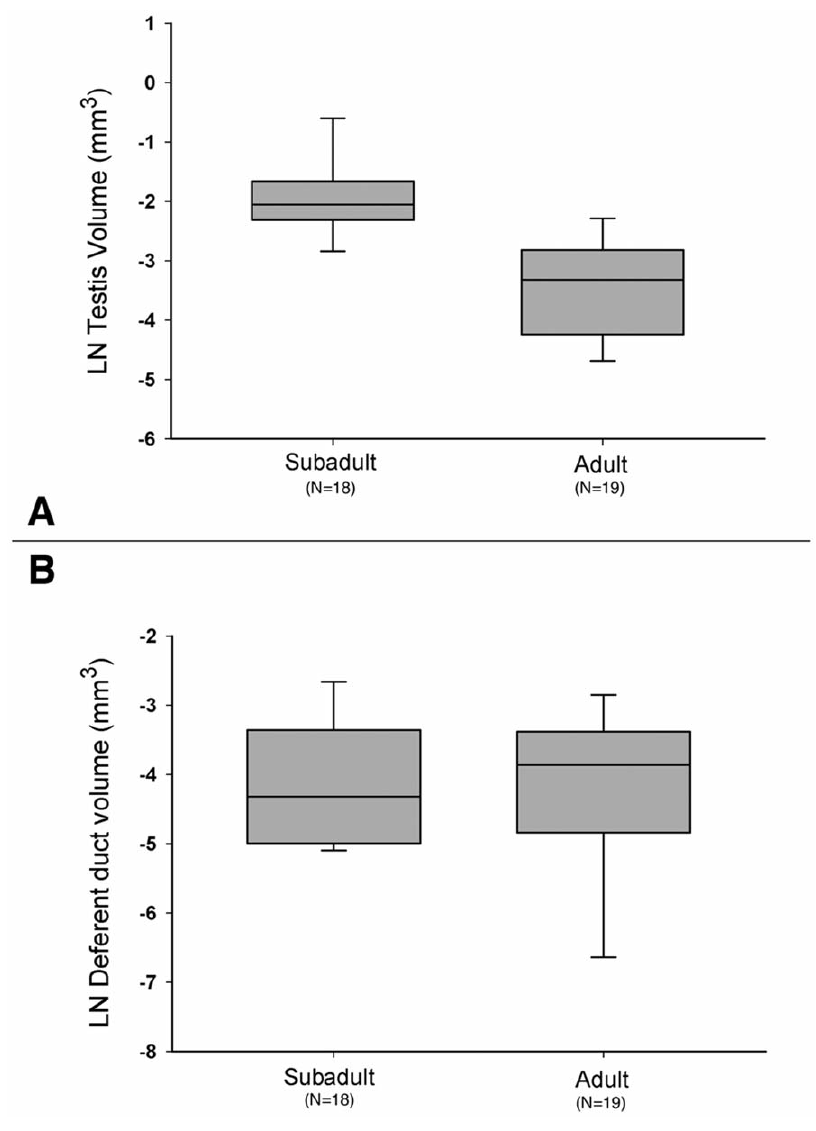
Figure 1. Testis volume vs. Deferent duct volume in Nephilaclavipes . (A) Testis volume in sub-adult versus adult males (N subadult =18, N adult =19; F 1,35 =34.7; P , 0.0001). (B) Deferent duct volume in sub-adult versus adult males (N subadult =18, N adult =19; F 1,35 =0.11; P=0.73).